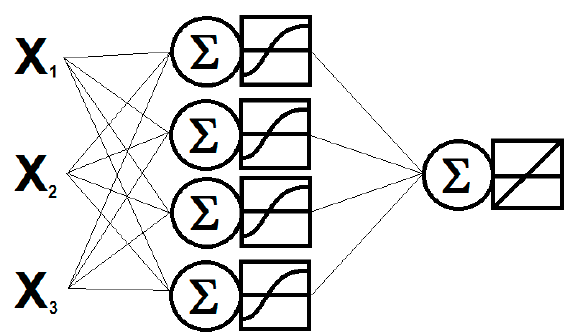
Figure 3. Representation of a neural network with three input data neurons, four hidden ones and one output data neuron